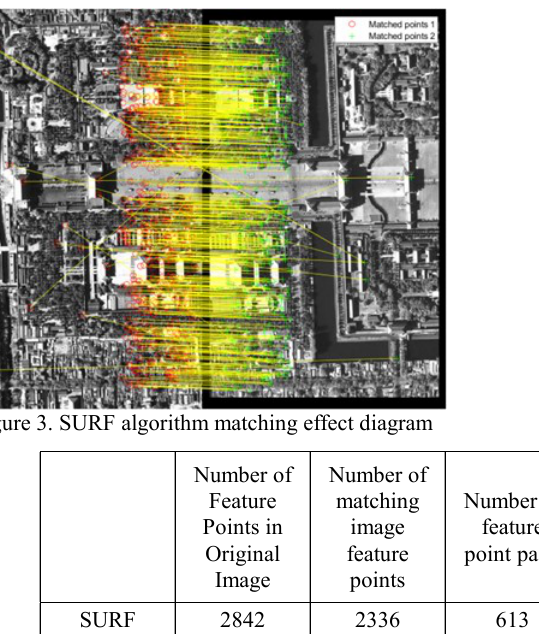
Figure 5. ORB algorithm matching effect diagram